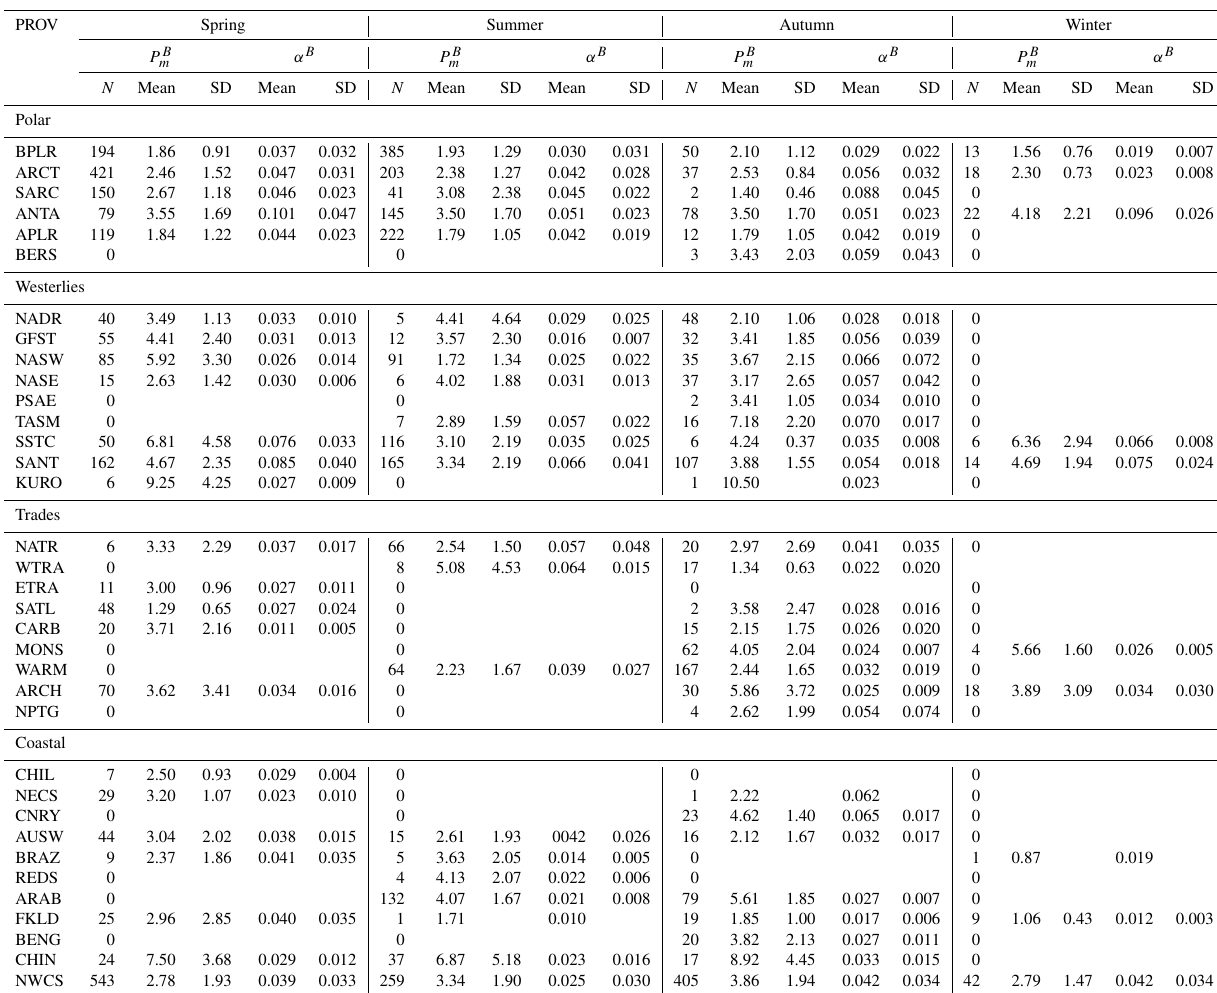
Table 5. Seasonal mean values and standard deviation for the photosynthetic parameters P B m and α B for each of the 35 Longhurst provinces. The blocked data represent the four primary biomes of the upper ocean: Polar (first quarter), Westerlies (second quarter), Trades (third quarter) and Coastal (fourth